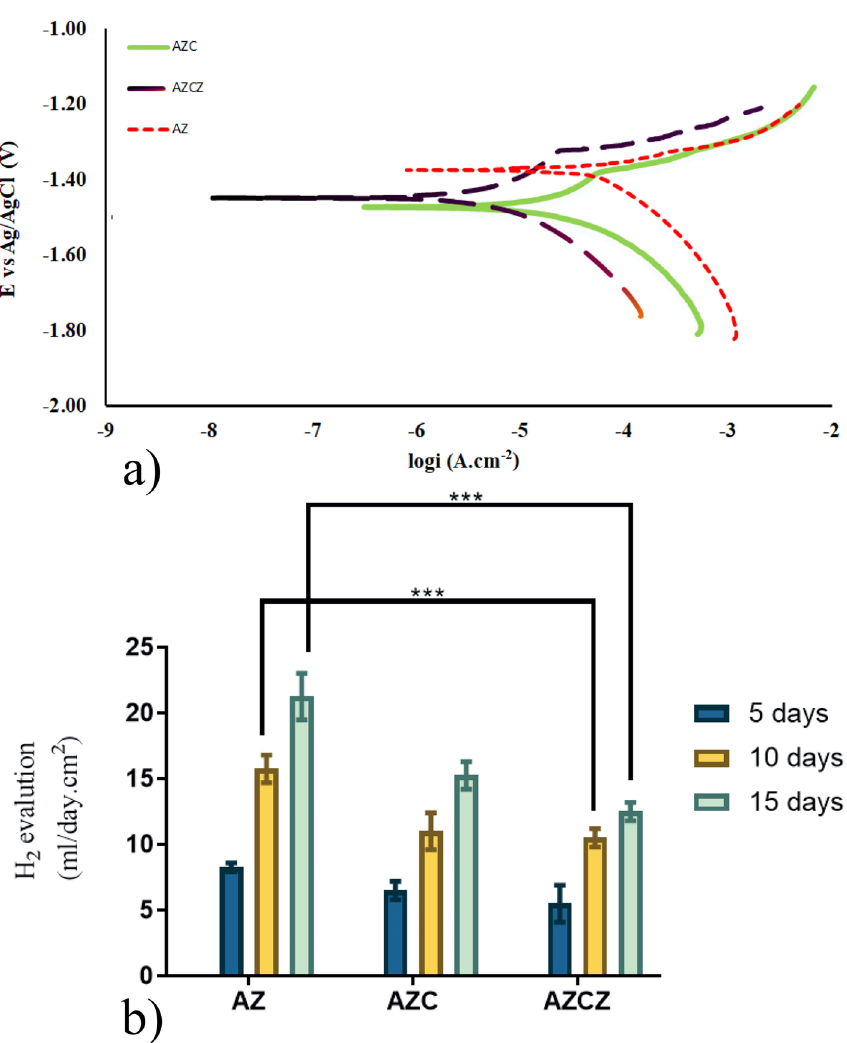
Figure 3. Electrochemical evaluations of the biodegradation of AZ91 alloy in SBF at 37 °C. ( a ) Tafel plots showing the effect of surface modification on the corrosion rate. ( b ) The average rate of hydrogen gas evolution at different time